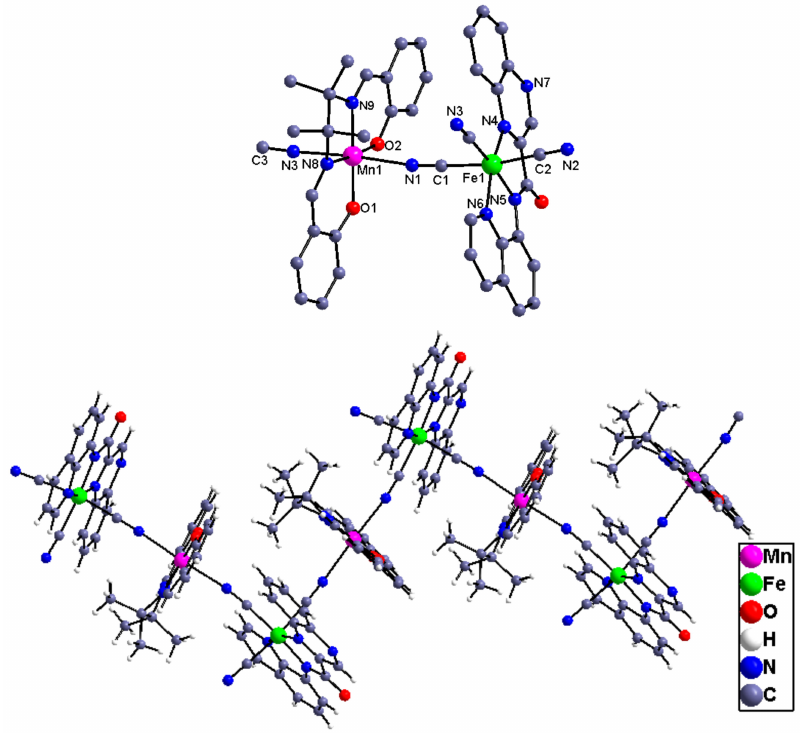
Figure 6. The independent binuclear and 1Dchain structure of complex 5 . The solvent content has been omitted for